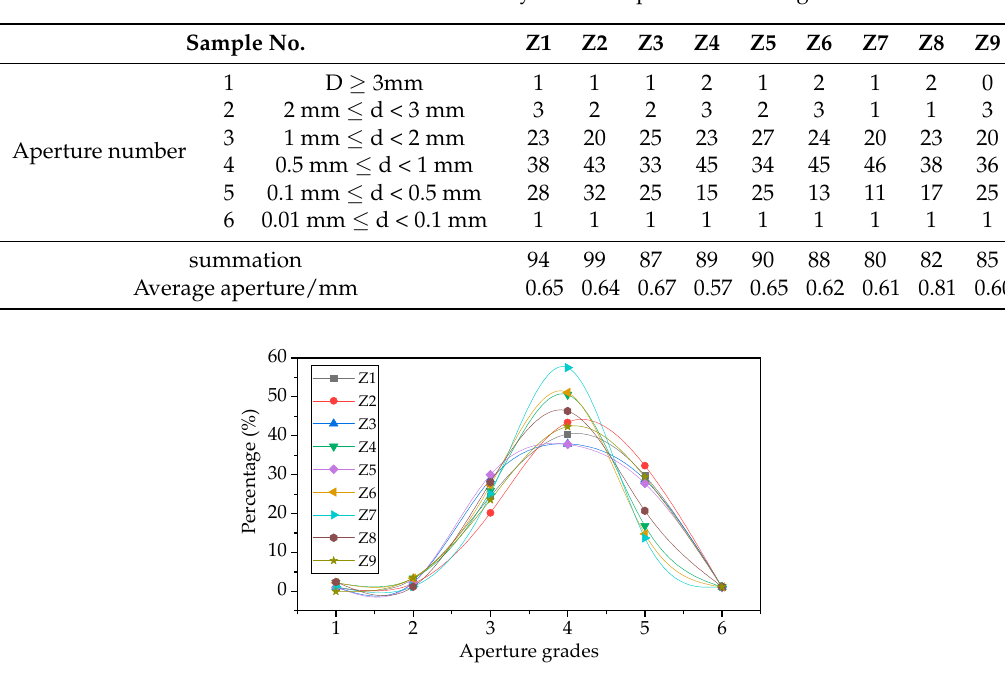
Table 4. The results of statistical analysis of the aperture in foam glass.